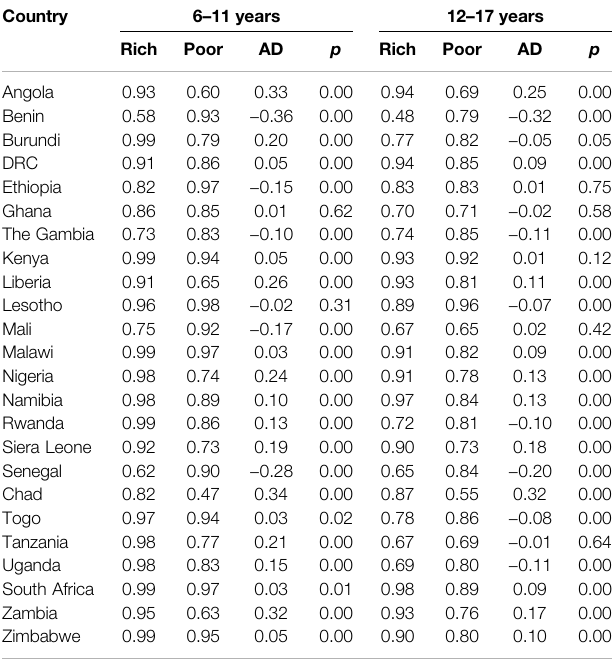
TABLE 3 | Enrolment rates and absolute difference by wealth and age group.